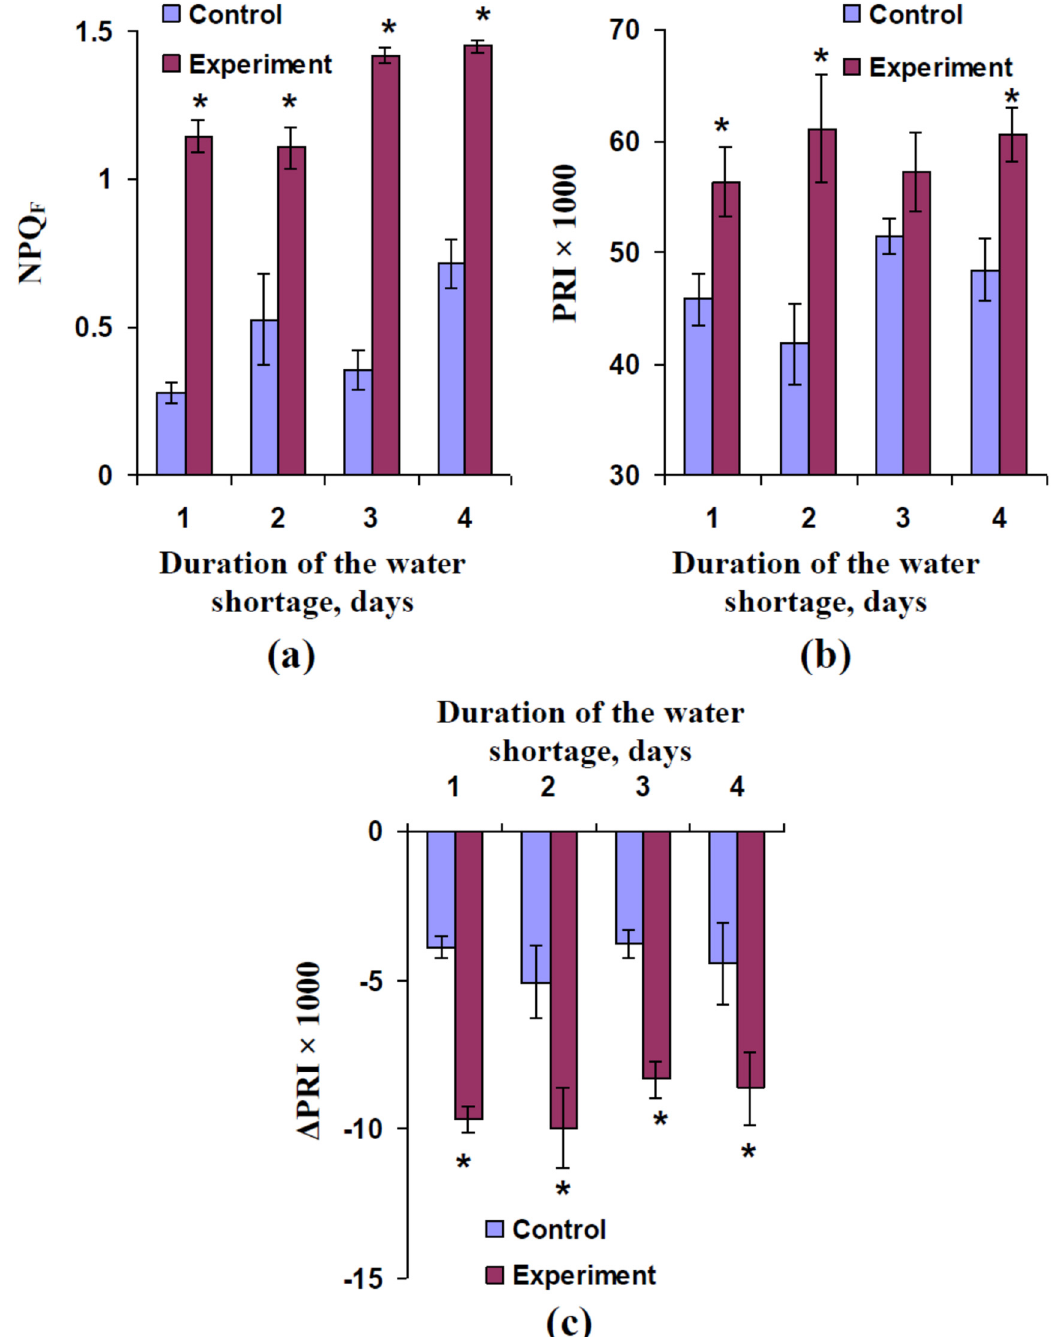
Figure 6. Dependences of the energy-dependent component of the non-photochemical quenching of fluorescence (NPQ F ) ( a ), the absolute value of PRI ( b ), and its change ( ∆ PRI) ( c ) in leaves of pea seedlings on the duration of the water shortage ( n = 12). Measurements were initiated after 15 min dark adaptation. Duration of AL action (617 nm, 280 μ mol m − 2 s − 1 ) was 10 min followed by 5 min of dark interval. The absolute value of PRI was measured before termination of illumination. ∆ PRI was measured as difference between PRI measured before termination of the illumination, and the initial PRI measured before initiation of the illumination. The water shortage was induced by elimination of irrigation in experimental seedlings; control plants were irrigated. * indicates that experimental and control parameters significantly differed ( p < 0.05). n is number of repetitions. Bars show standard errors.